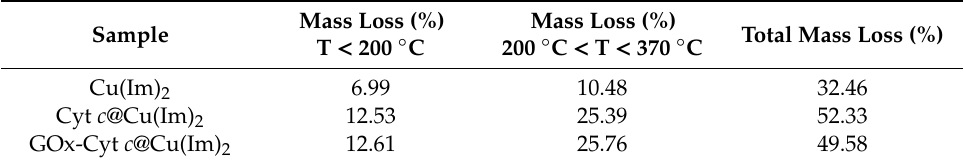
Figure 2. ( a ) FTIR spectra of Cyt c , Cu(Im) 2 , Cyt c @Cu(Im) 2 and GOx-Cyt c @Cu(Im) 2 ; ( b ) TGA curves of Cu(Im) 2 , enzyme@Cu(Im) 2 in N 2 atmosphere. Table 1. Mass loss (%) of Cu(Im) 2 and enzyme@Cu(Im) 2 composite.